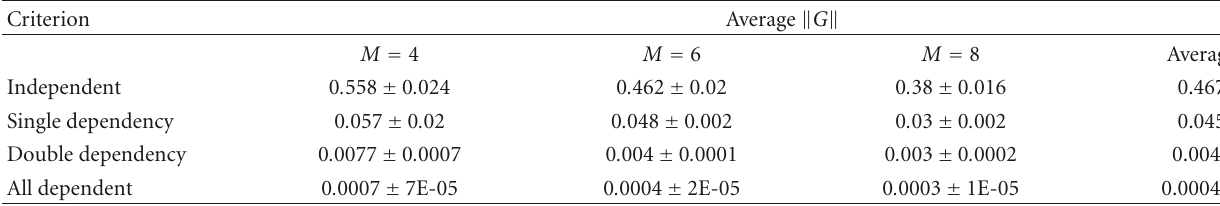
Table 2: Average and standard deviation of (cid:3) G (cid:3) for the four criterions.